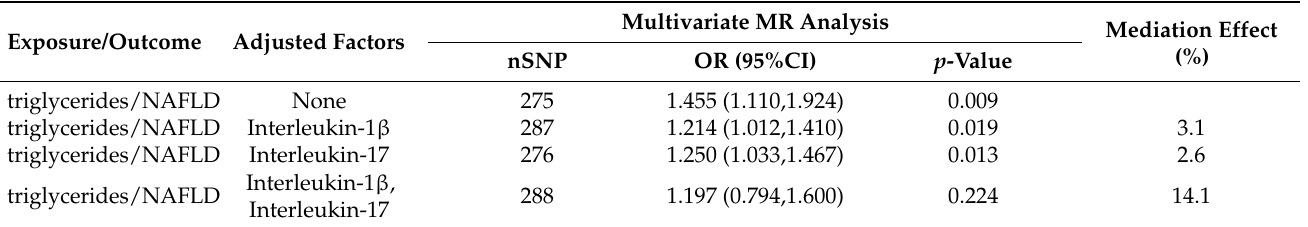
Table 4. Multivariate MR analysis of the direct effect of IL-1 β and IL-17 on